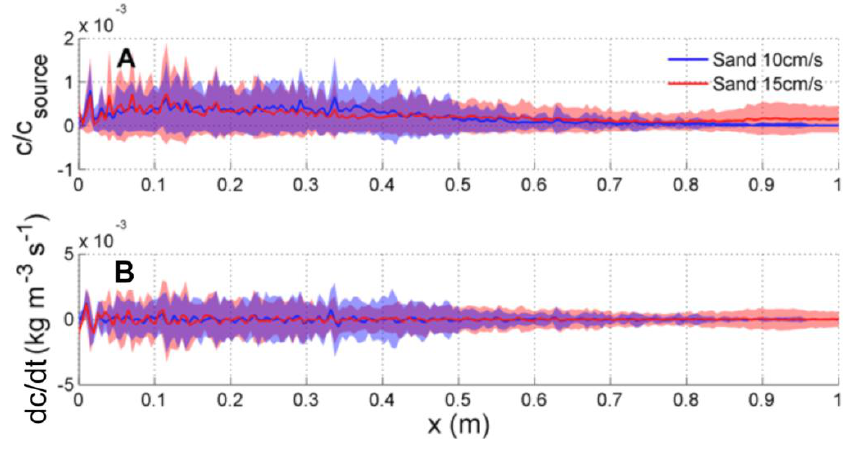
Figure 12. ( A ) Normalized concentration and ( B ) temporal rate of change of concentration ( dc/dt ) along the centerline through the length of the flume at z = 5 cm. The solid line shows mean values and the shaded region shows the region of ±1 standard deviation around the